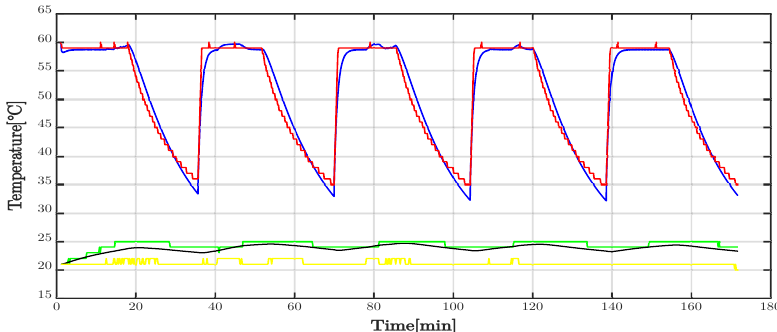
red lines represent the experimental and simulated temperature for zone 1. In addition, the green and black lines denote the experimental and simulated internal temperature in zone 2. In this case, the objective function used for the tuning process was the sum of the experimental and simulated results for each zone, i.e., F objective = e 1 + e 2 , using e 1 as the percentage error for zone 1 and e 2 the error for zone 2. The errors obtained were 2.94% and 2.97% for zone 1 and zone 2, respectively.